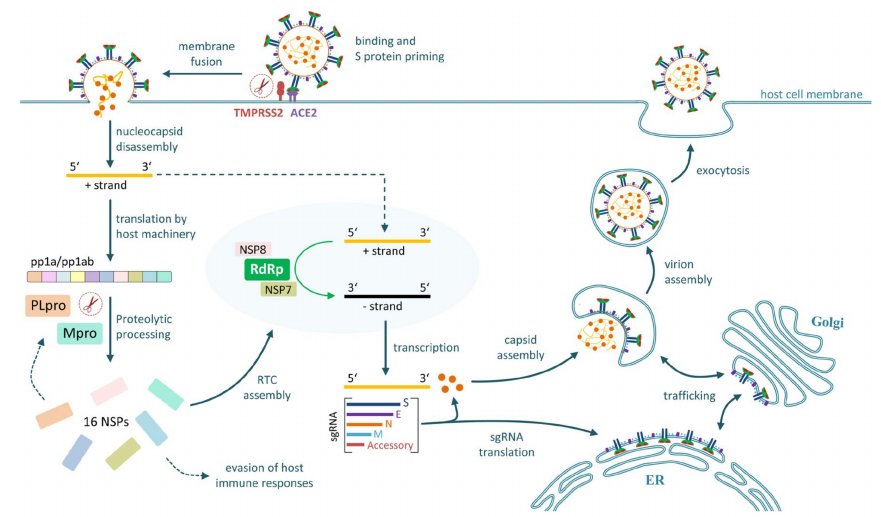
Figure 2. SARS-CoV-2 replication and transcription cycle in infected cells. Schematic representation of the processes involved in the replication of SARS-CoV-2 in infected host cells. For details see Sections 2.2 and 2.3.